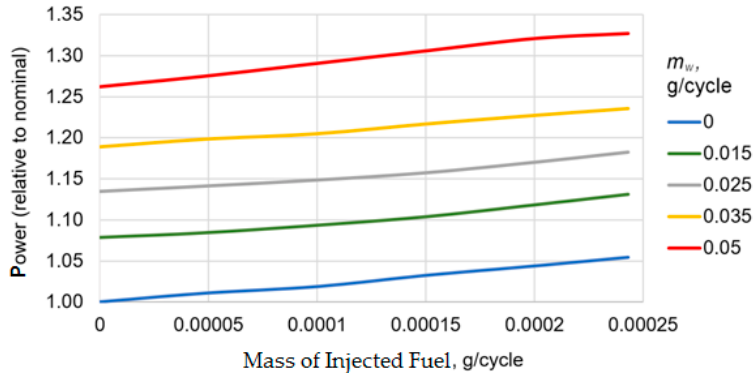
Figure 11. Dependence of the relative engine power on the cyclic fuel and water supply ( m w ) to the intake manifold. (Source: Authors).